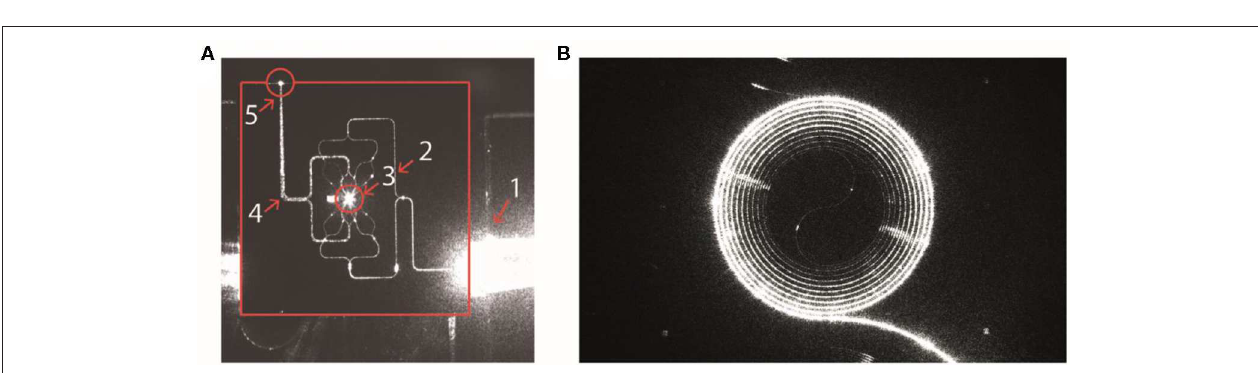
FIGURE 7 | Integrated photonics based lab-on-a-chip Raman spectroscopy. (A) Device type 1: Camera image of a device with 16 waveguides for trapping and four waveguides for detection. The device is actuated with light from an input fiber that is embedded in a fiber array unit (FAU) at the lower right-hand side. The various structures light up as a result of light scattering, causing some saturation of the camera. The solid red lines indicate the chip edges. 1, FAU; 2, excitation-waveguide circuitry; 3, microfluidic bath with the central trapping region; 4, detection-waveguide circuitry; 5, light from the trap that is coupled out by the detection waveguides. Here, the detection waveguides collect light as a result of direct illumination and scattering (from Loozen et al. (53)). (B) Device type 2: Spiral waveguide with the Raman pump light traveling inside the waveguide. The Raman signal is (partially) scattered back into the waveguide and collected at the front entrance. Reproduced with permission from Lee